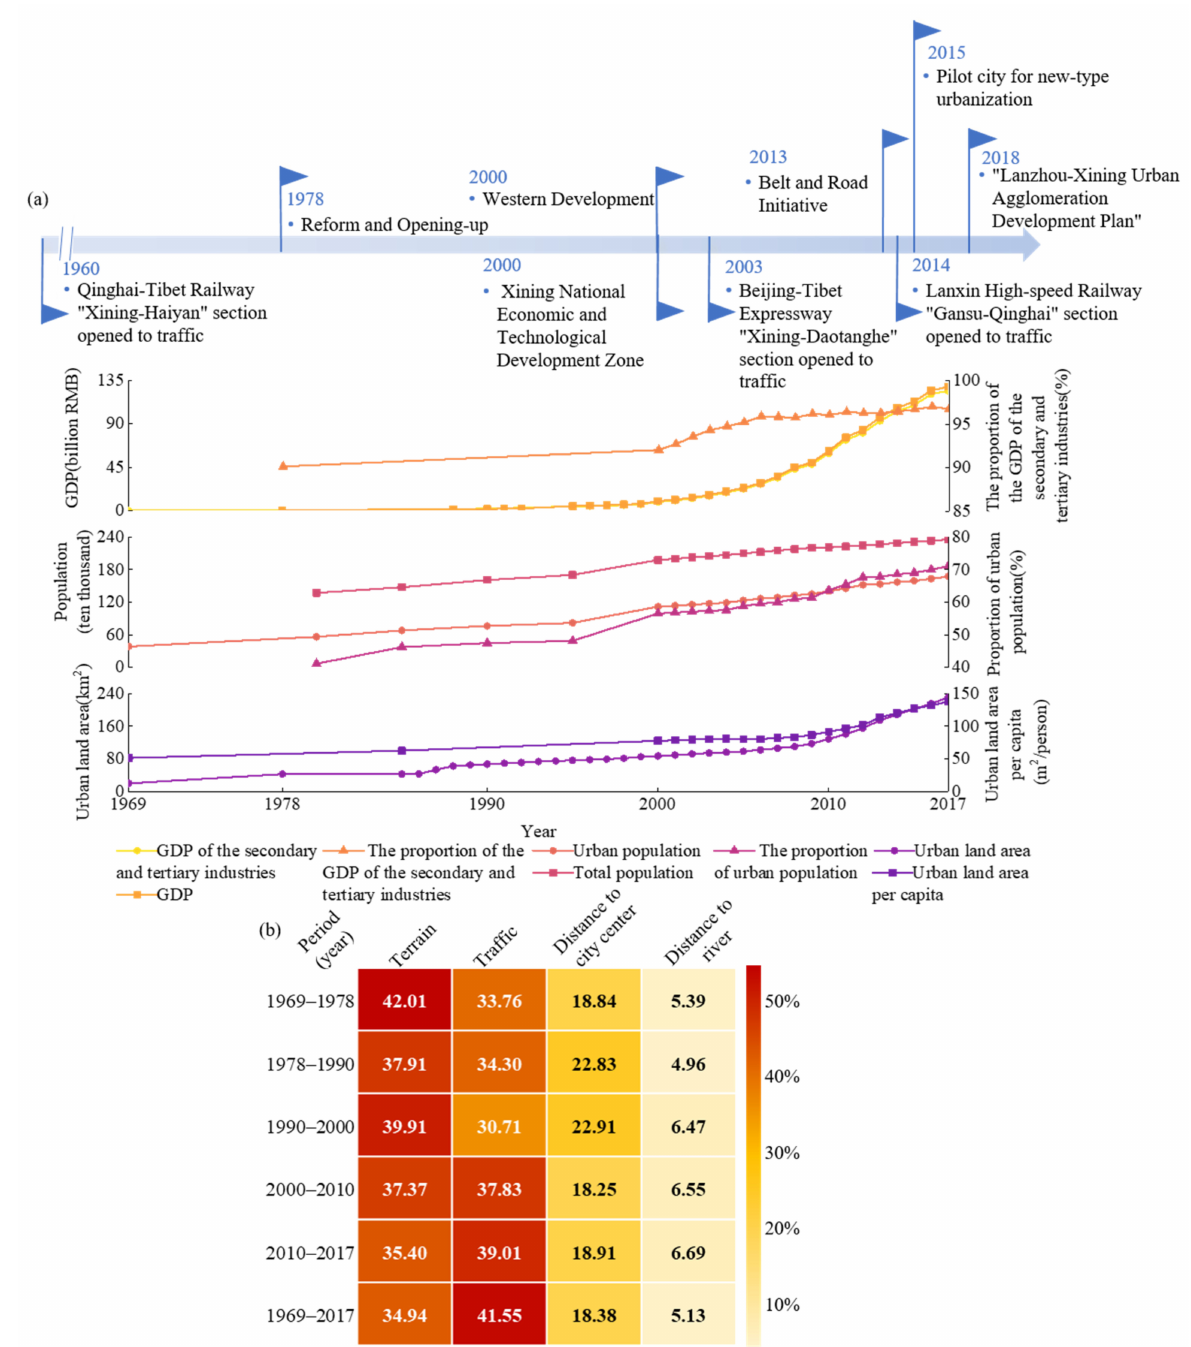
Figure 6. Influencing factors of urban expansion in Xining City. ( a ) relevant policies and socio-economic factors; ( b ) the importance of location factors for urban expansion in different time